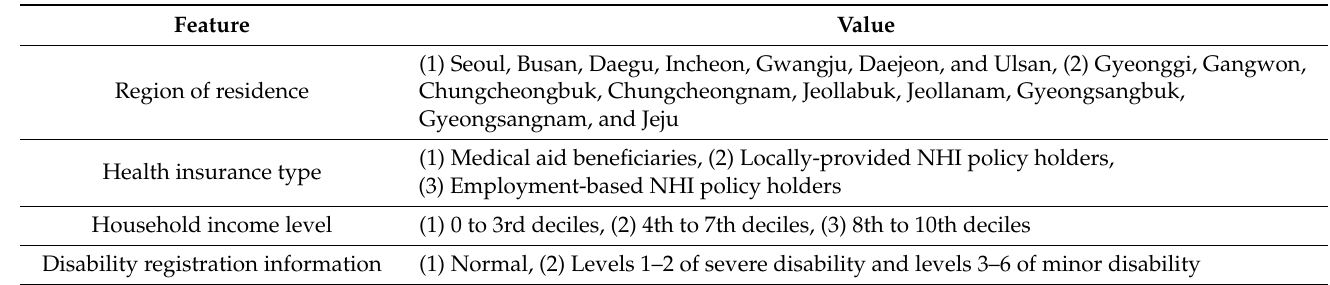
Table 2. Feature engineering on categorical data.